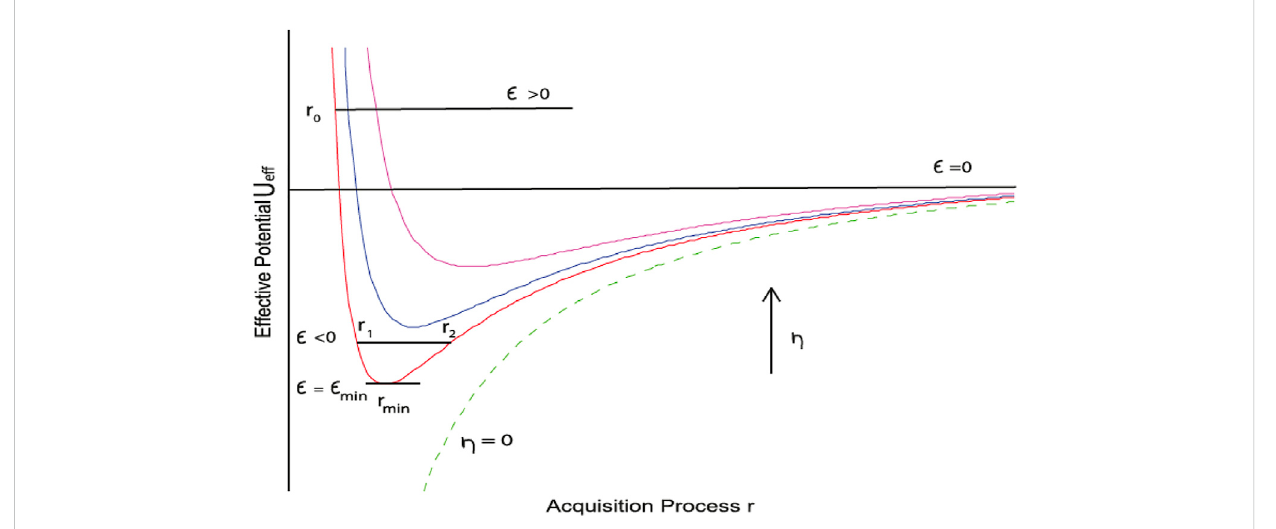
FIGURE 3 Effective potentials U eff with different values of η [12,13].